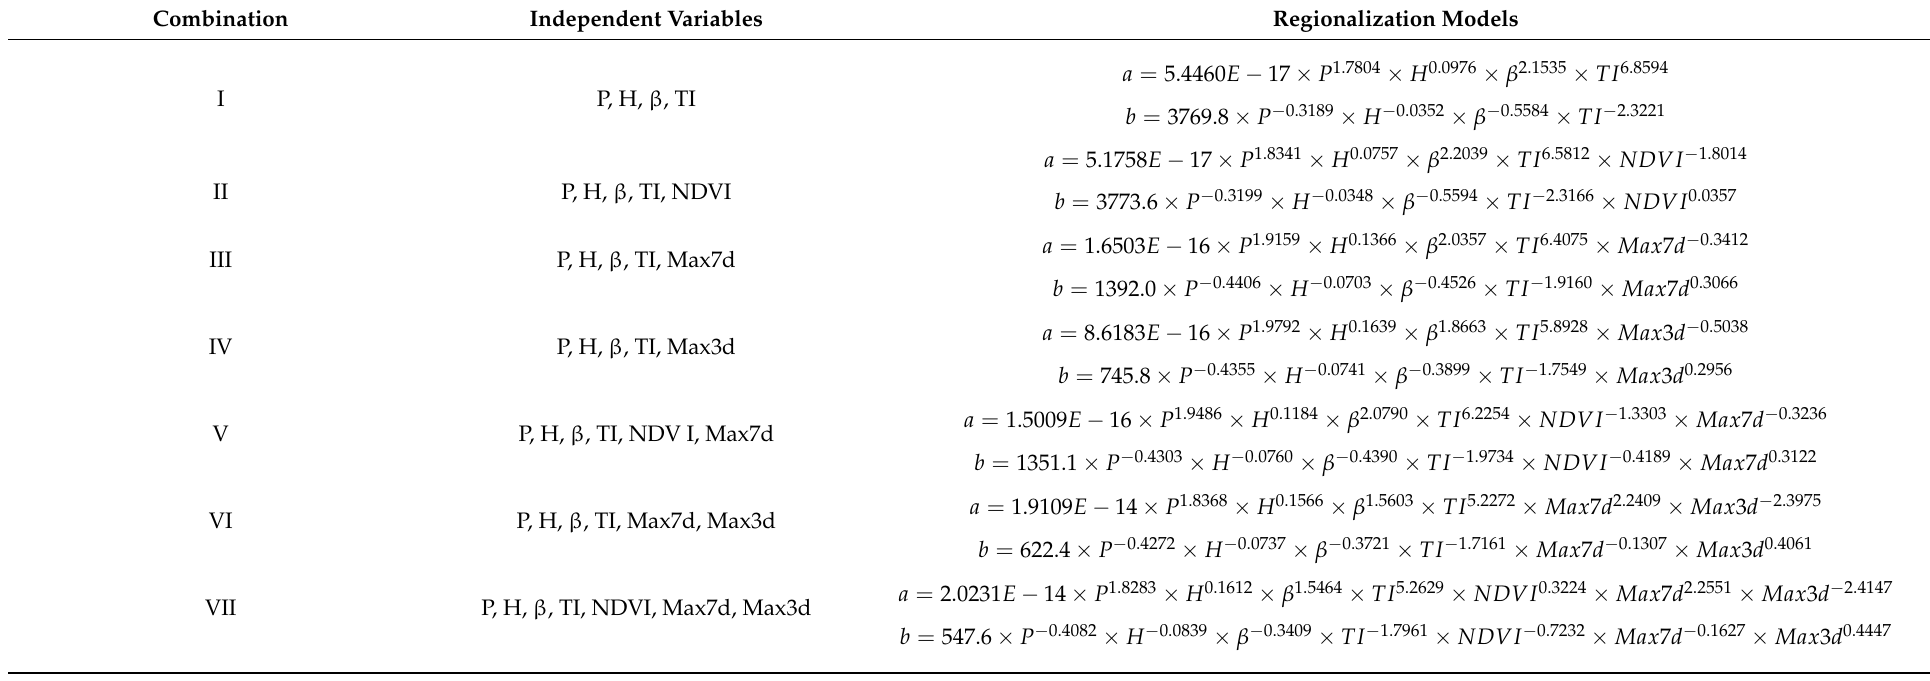
Table 3. Different combinations of independent variables and their regionalization